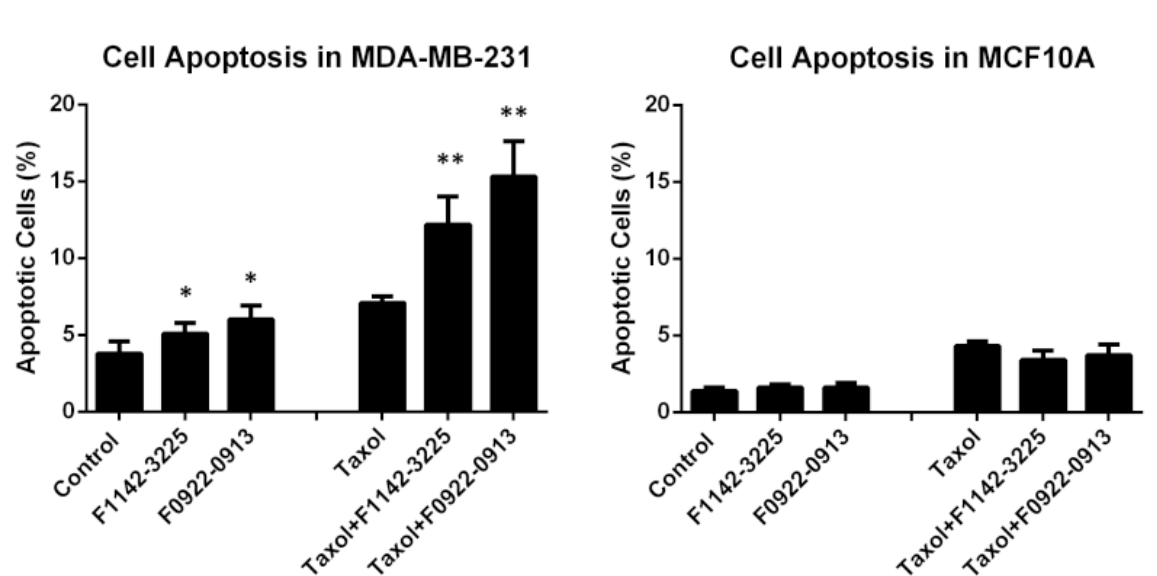
Figure 9. Cell apoptosis induced by the inhibitors with or without taxol in TNBC and MCF10 A cell lines. Cell apoptosis was determined by eBioscience TM Annexin V Apoptosis Detection kit APC in MDA-MB-231( A ) and MCF10A ( B ) cell lines treated with either F2114-3225 or F0922-0913, in the presence or absence of taxol for 24 h. Data are reported as % of DNA synthesis vs. control (100%). Each point represents the mean of four replications (mean ± SD). Statistical significance by one-way ANOVA; * p ˂ 0.05 vs. control (ctrl); ** p ˂ 0.01 vs. control (ctrl).